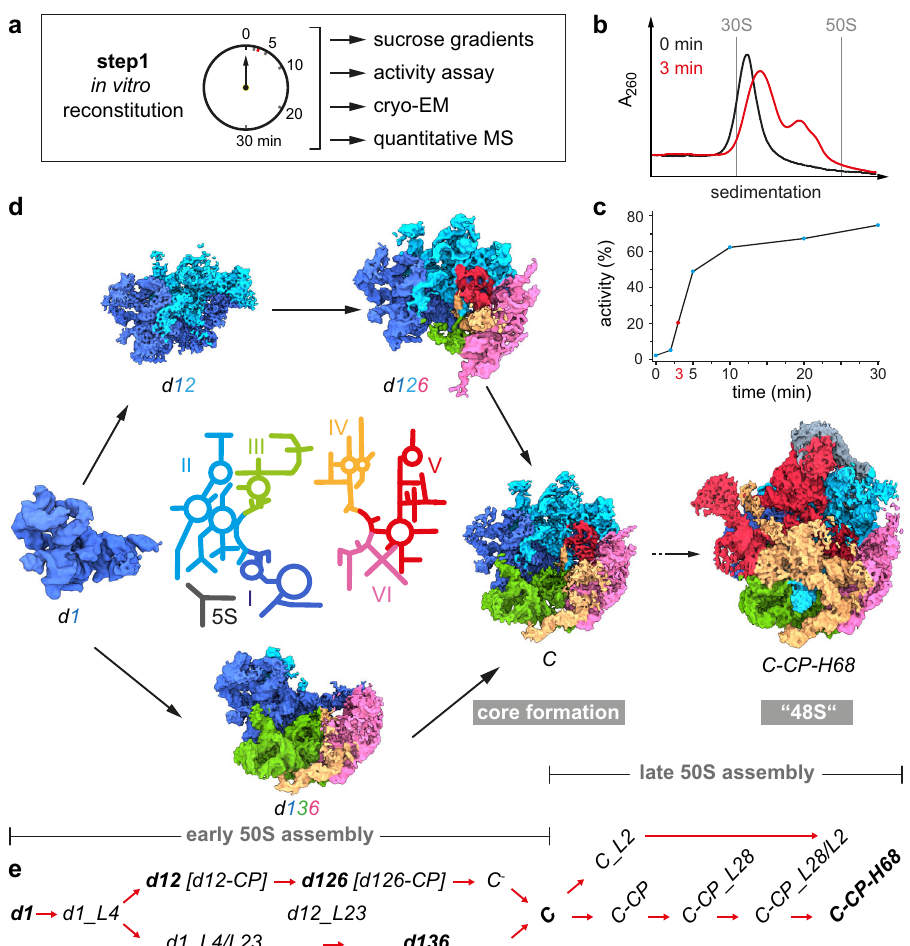
Fig. 1 | Time course of 50S step 1 in vitro reconstitution with structural and biochemicalanalyses.a Experimentalsetup. b Sucrosegradientpro fi lesofinvitro reconstitutionsamplesincubatedfor0min(black)or3min(red),respectively. c In vitrotranslationassayindicatingtherelativeactivityofsubunitsaftertheindicated timeofincubationunderstep1conditionsplussubsequentincubationunderstep2 conditions for 90min. Data are presented as mean values based on n =2 technical